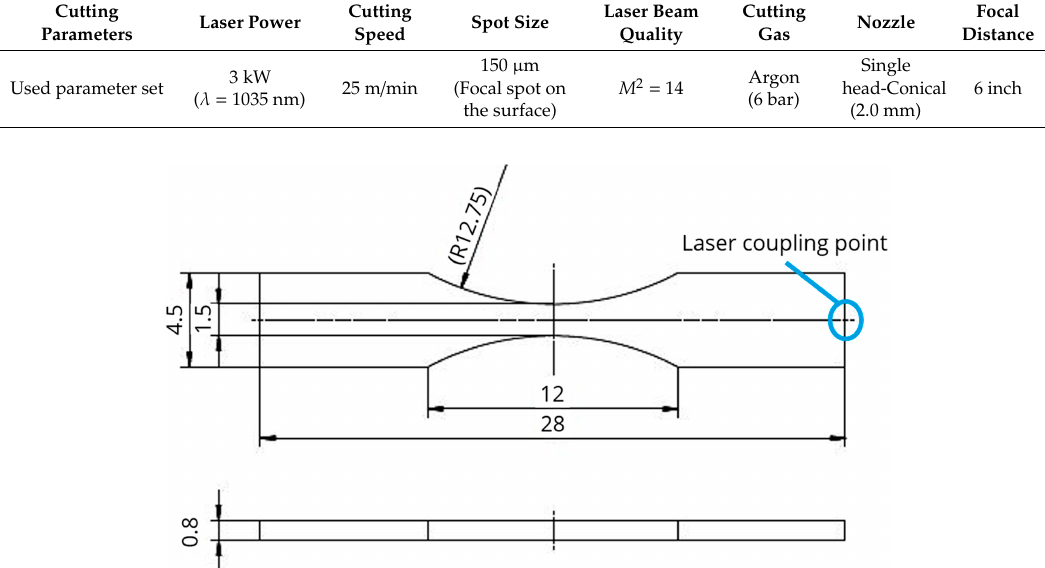
Figure 1. Fatigue sample geometry of Ti-6Al-4V-ELI with a marked laser coupling point. Dimensions in mm.